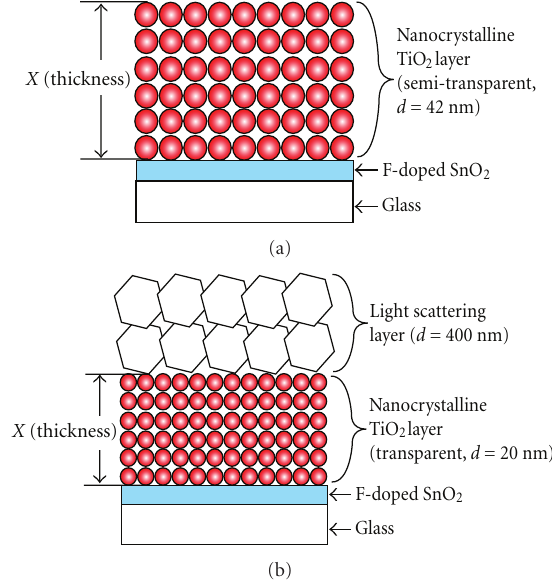
Figure 1: Structure of DSC with single-layer (a) and double-layer (b) structures of nanocrystalline-TiO 2 electrodes. X’s in figures show the thickness of nanocrystalline-TiO 2 electrodes that was varied for the optimization of high-e ffi ciency DSC (Figures 5, 6 and 7). (7) A high-activity Pt counter electrode for I − / I − ( < 8 Ω ) [10].